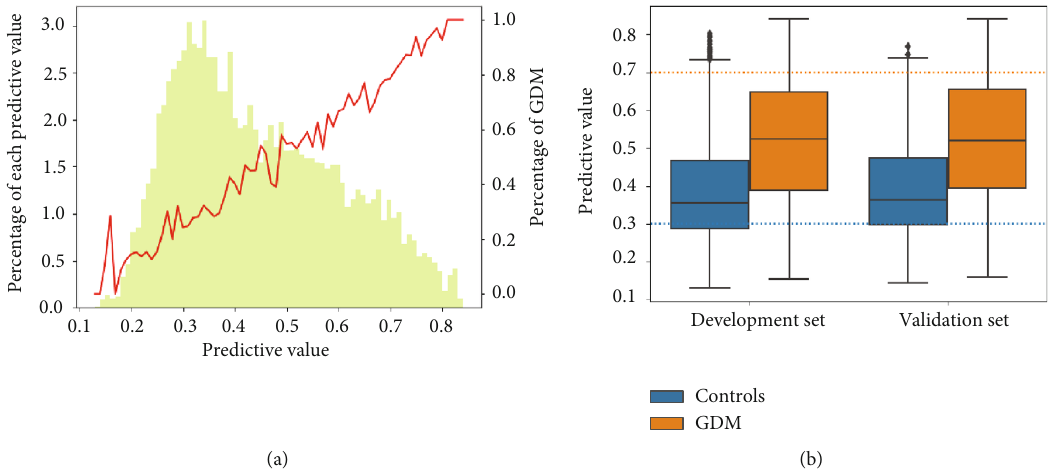
Figure 5: Predictive values for participants with and without GDM in the cohorts. (a) Distribution of predictive value and its relationship with the observed GDM in the combined cohort (development and validation cohort). (b) Distribution of predictive values in the development and validation cohort. Data are presented as median and interquartile